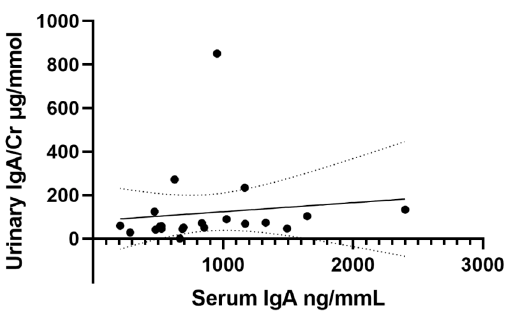
Figure 4. Correlation between urinary IgA/Cr and serum IgA concentrations in all patients with linear regression best-fit lines (r = 0.120; p = 0.603) and 95% confidence bands.